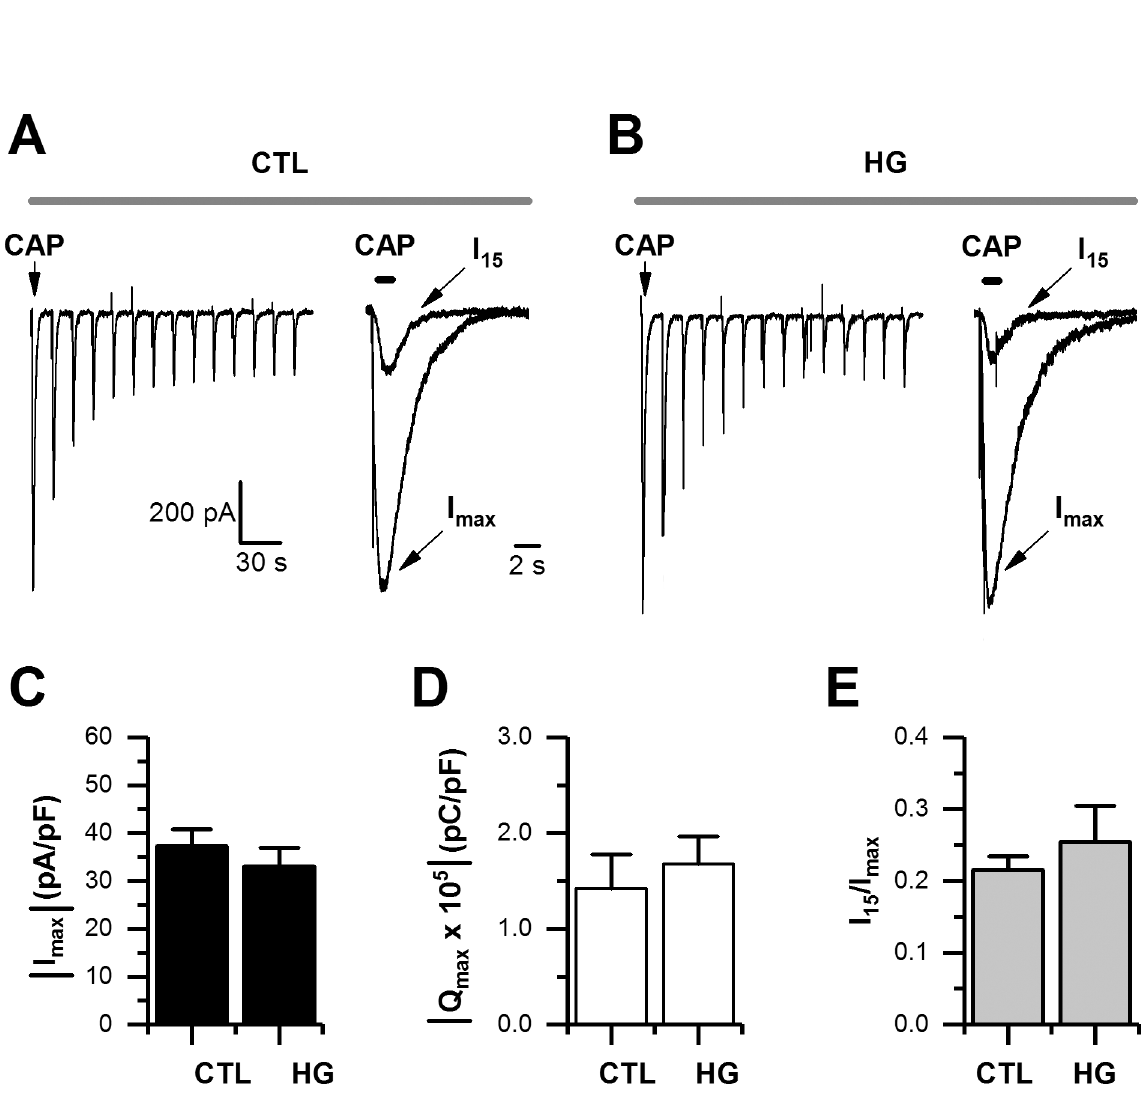
Fig 5. High glucose failed to potentiate CAP-evoked currents in cultured DRG neurons from RAGE KO mice. A-B, representative traces of CAP-evoked currents recorded during whole-cell voltage-clamp recording (holding potential set at -60 mV) from DRG neurons maintained in either control (CTL) or high glucose (HG) conditions. C-E, bar graphs summarize maximal current (I max ) density (C), maximal current charge (Q max ; D), and current rundown calculated as the ratio I 15 / I max (E). All data are represented as mean ± SEM, n = 14 for each condition. The absolute current density and charge were used in C and D for simplicity. Statistical analysis by unpaired t -test (C-D), and Mann-Whitney test (E); no significant differences between treatments were found.